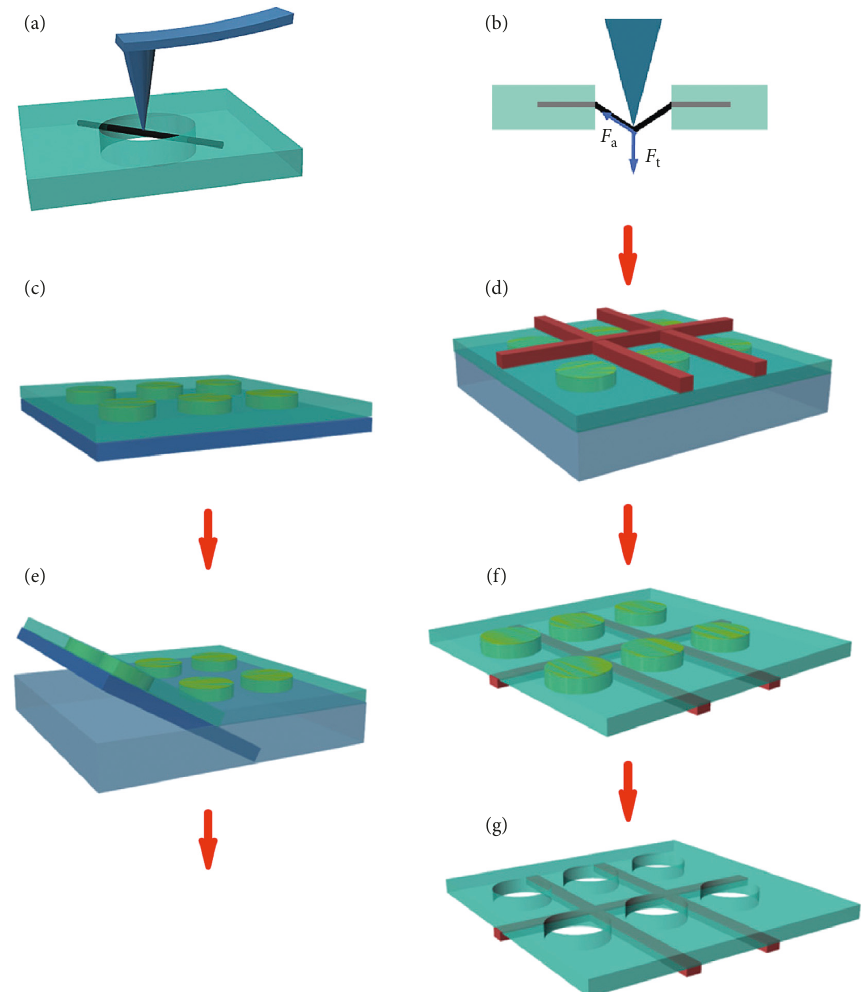
Figure 4: (a and b) Schematic diagram of the pull-out process applied to an individual carbon nanotube suspended within a free-standing polymer thin film using an atomic force microscope. Schematic diagram of the fabrication process of a suspended holey film as being formed from a polymer blend: (c) a hydrophobic polymer thin film coated on the surface of a hydrophilic glass slide using a dip-coating method, (d) release of such a film from the glass slide by water, (e and f) transfer of the film to a grid made of copper, and (g) hole-opening using cyclohexane as a solvent and then using a heat treatment method (adapted with permission from reference [101]; copyright 2017, Elsevier